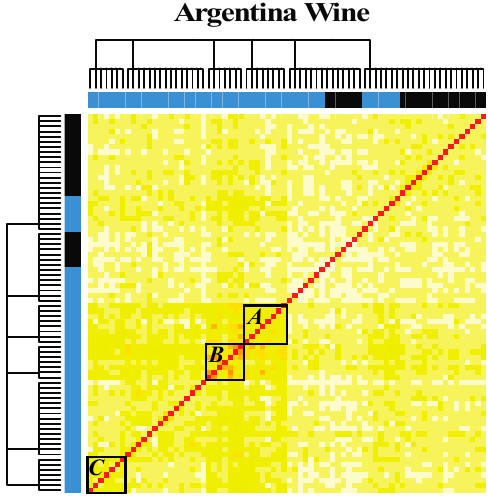
Figure 5. Heat map for the 74 characteristics of the Malbec wines from Argentina. The heat map is computed using DCG and the mutual entropy distance measure (see text for details). Chemical and sensory characteristics are highlighted in blue and black, respectively. Three subgroups of those characteristics are selected, and labeled as A, B and C on the heat map. The color scale yellow-red used to represent the heat map corresponds to the interval [0,1] for the mutual entropy, with red mapping to 0 and yellow mapping to 1.